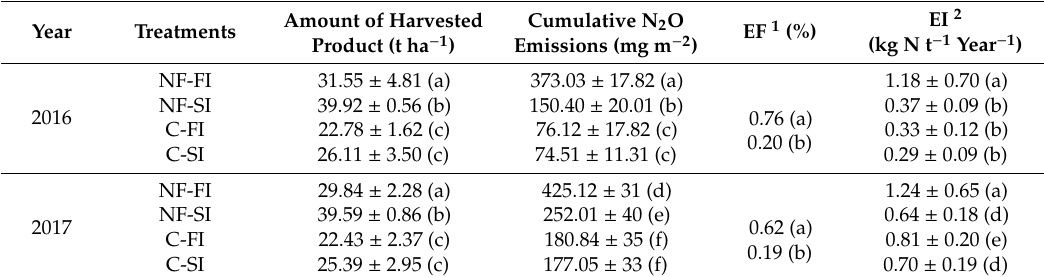
Table 4. Harvested product of potato, cumulative soil N 2 O emissions, soil N 2 O emission factor (EF), and soil N 2 O emission intensity (EI) in 2016 and